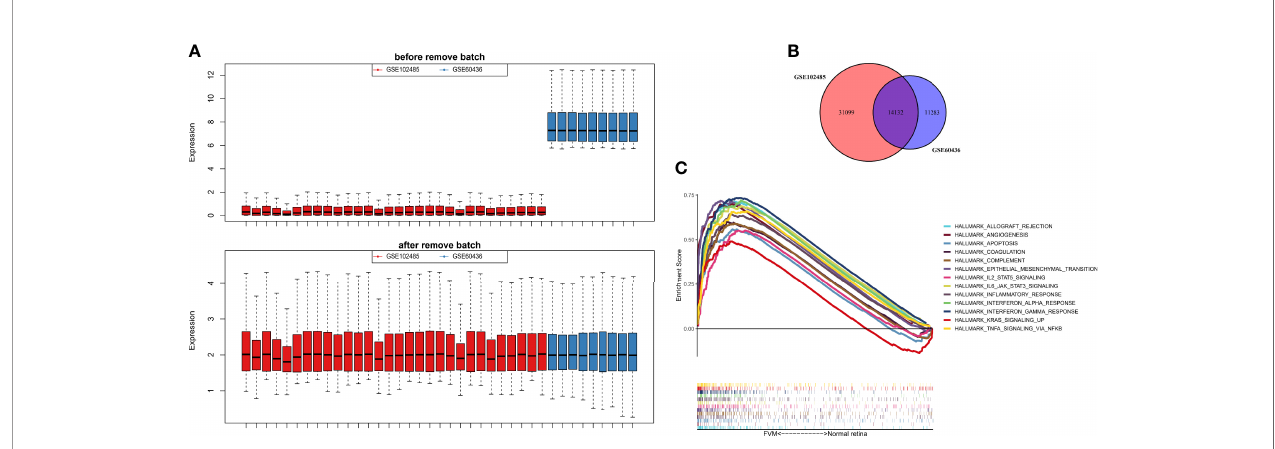
FIGURE 2 | Data preprocessing and gene set enrichment analysis (GSEA). (A) Box plot for the expression pro fi les before and after normalization. (B) Venn diagram showing the intersection between expressed genes from two datasets. (C) GSEA plot for the signi fi cant Hallmark sets for FVM group (FDR<0.25, p <0.05).